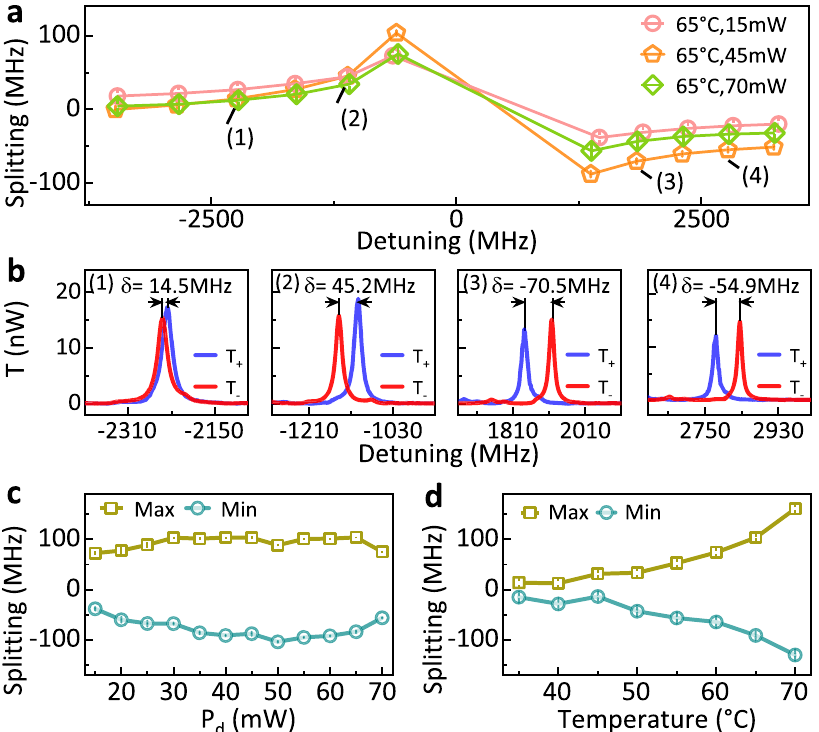
Fig. 4 Mode frequency shift due to dispersive non-reciprocity. a The resonant frequency shift of two circularly polarized modes at different drive laser power levels ( P d ) and fi xed cell temperature of 65 ∘ C. When the frequency of signal is near-resonant to the atoms (blue shadow region in Fig. 2c), the absorptive effect dominates and the resonances for T − are suppressed. The dispersive shift can not be distinguished in this regime. b The relative mode spectral shifts ( δ ) at four different cavity detunings labeled in a . c and d The extracted maximum and minimum mode frequency shifts against P d and different cell temperatures. In all studies, the signal laser power is fi xed at P s = 20 μ W, and error bars denote standard